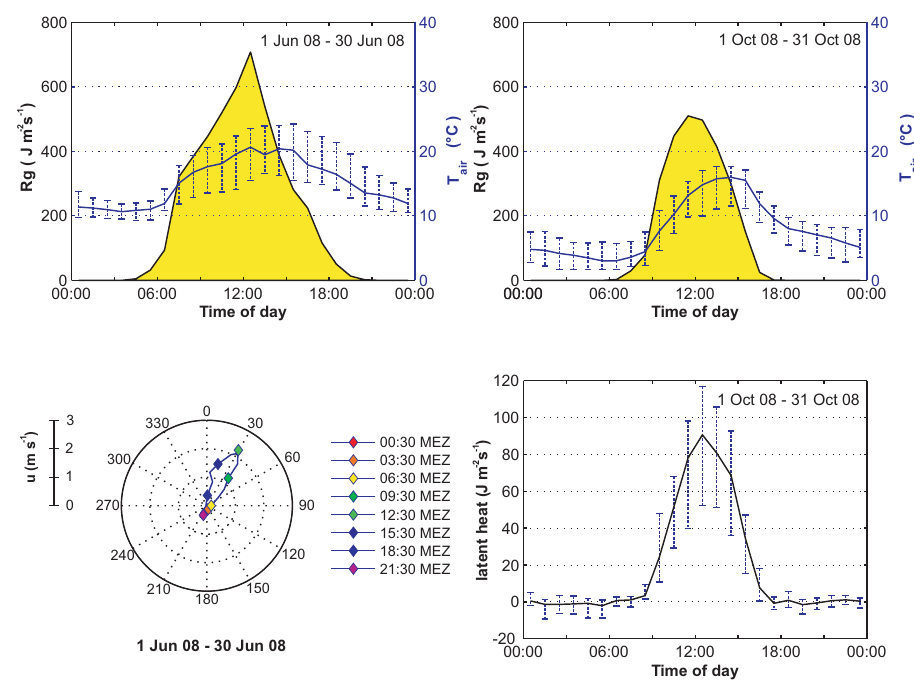
Fig. 9. Upper panels: Median diurnal cycles of the temperature including the 25% and 75% percentiles overlaid on the diurnal cycle of the global radiation for the months June and October 2008. Lower left and right panel: Polar plot of the median diurnal cycle of the horizontal wind speed in June 2008 and diurnal cycle of the latent heat flux for October 2008. Table 2. Minimal and maximal amount of half-hours used to calculate the hourly flux medians for diurnal patterns (Fig. 8) in June and October after applying the quality control on m/z 33 and m/z 137 (partitioned to nighttime and daytime according to median radiation). Each hourly flux median was calculated from at least 18